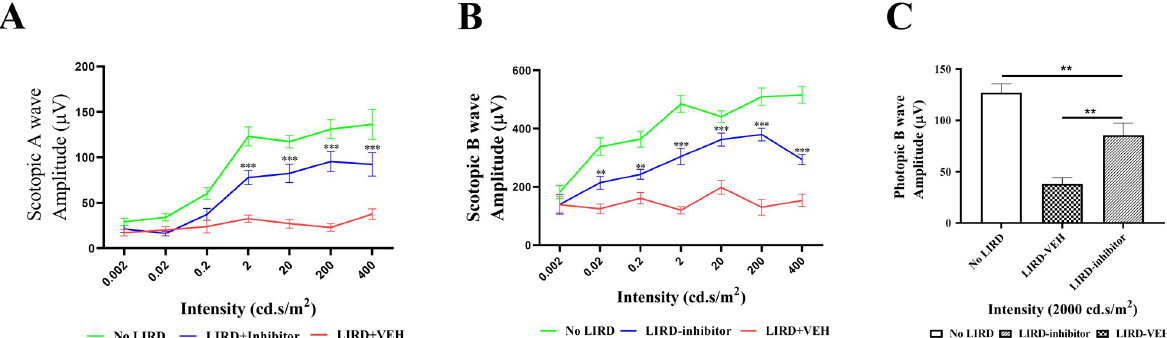
Fig 7. ERG responses of ( ± )-RPE65-61 treated LIRD mice. Retina photoreceptor function was measured by ERG 5 days after light exposure. (A) Comparison of averaged scotopic a-wave amplitudes from three mouse groups. Seven different stimulus intensities were used, ranging from 0.002 to 400 cd s/m2. (B) Comparison of the averaged scotopic b-wave amplitude from the three groups. (C) Comparison of the averaged photopic b-wave amplitude from the three groups: No LIRD control, LIRD + Vehicle or LIRD + ( ± )- RPE65-61 , Student’s t-test was used (n = 8, mean ± SEM, � P < 0.05, �� < 0.01 and ��� <